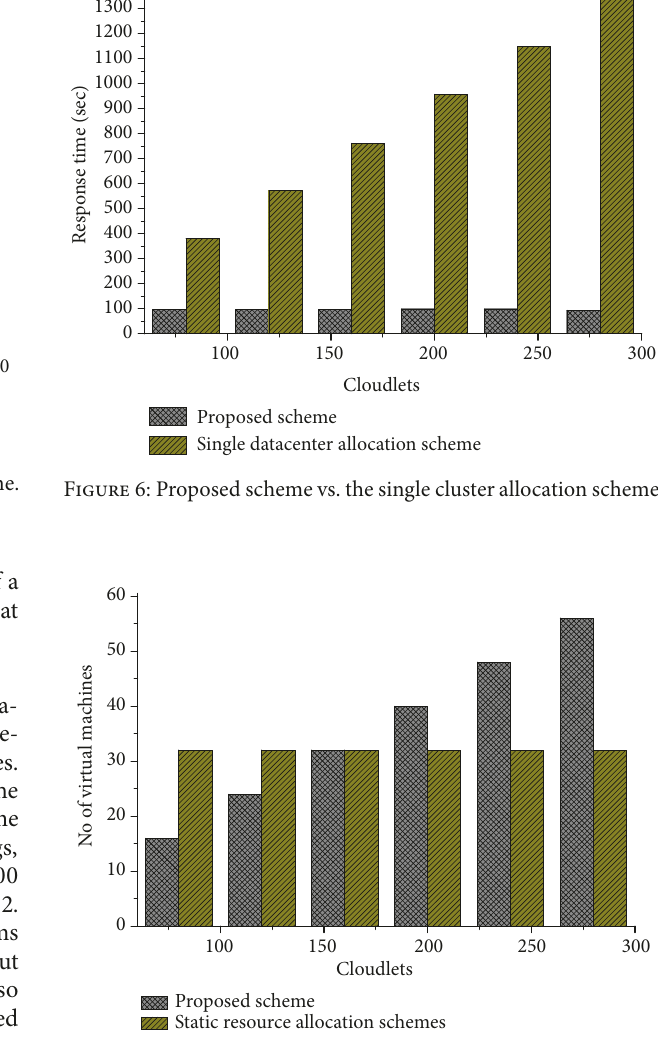
Figure 7: Proposed scheme vs. static resource allocation